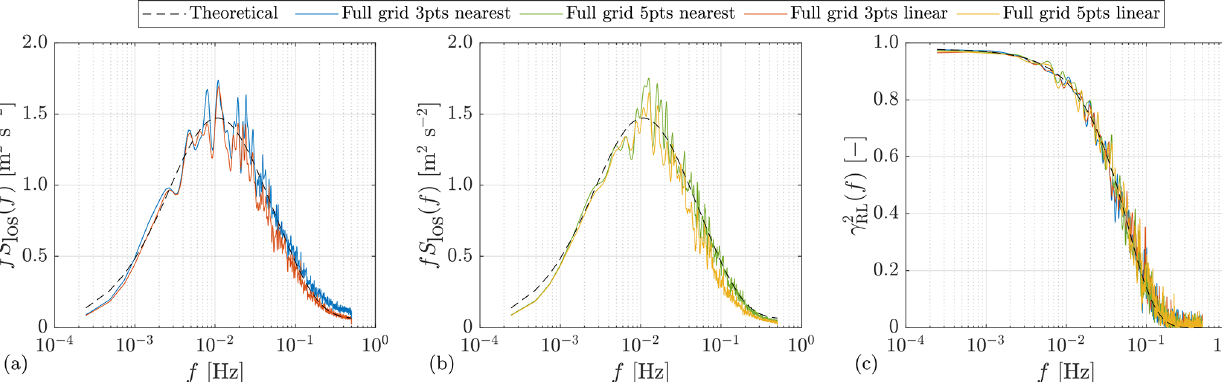
Figure 11. Comparison of the simulated lidar spectral properties with different discrete weighting functions and interpolation methods. (a, b) Auto-spectra of LOS measurements. (c) Coherence between rotor effective wind speed (REWS) and lidar-estimated REWS. The discrete weighting functions: three-point and five-point cases in accordance with Fig. 7. The interpolation methods: linear and nearest. The simulated auto-spectra are averaged with 16 samples.